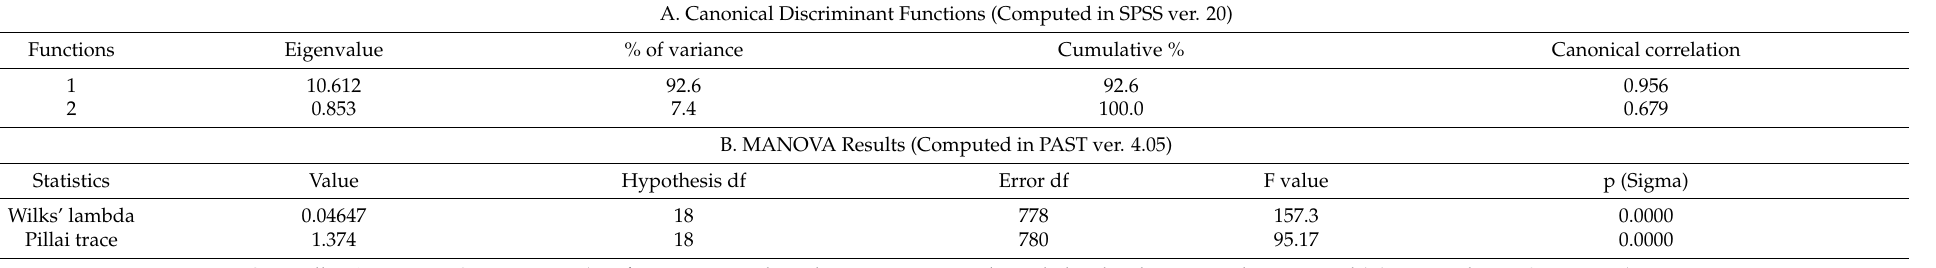
Table 6. The results of the discriminant analysis and pairwise